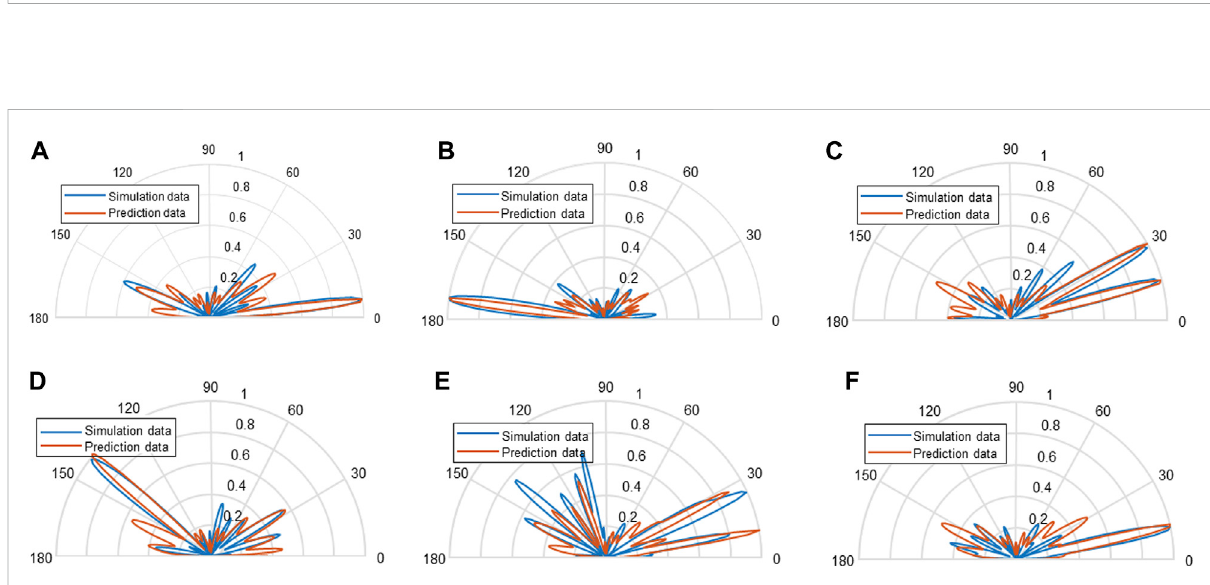
FIGURE 5 Far- fi eld prediction results. (A) . MSE = 0.0142; Accuracy = 91.26%. (B) . MSE = 0.0201; Accuracy = 88.40%. (C) . MSE = 0.0222; Accuracy = 88.74%. (D) . MSE = 0.0265; Accuracy = 90.14%. (E) . MSE = 0.0392; Accuracy = 89.54%. (F) . MSE = 0.0161; Accuracy =